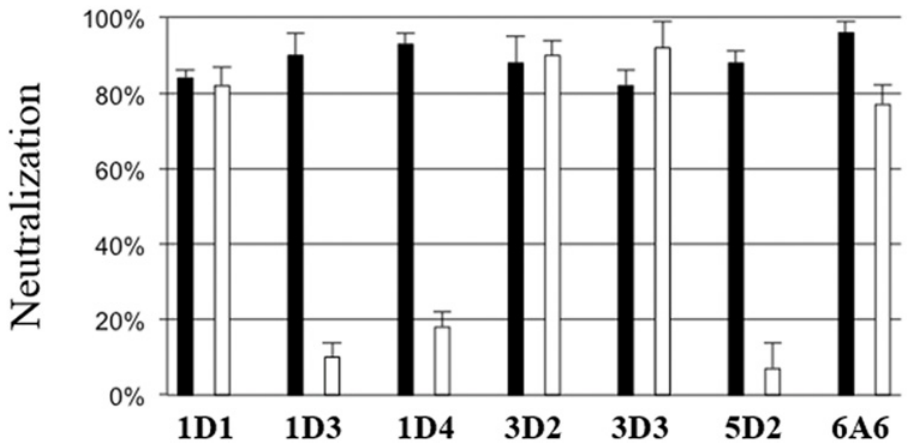
Fig 2. Monoclonal antibodies neutralization mechanism after pre (black) or post (white) MCPyV pseudovirions attachment. For the detection of neutralizing antibodies, COS-7 cells (10 4 /well) and MCPyV luciferase pseudovirions (0.2 RLU) were used. For the pre attachment determination, pseudovirions were mixed with monoclonal antibodies supernatants diluted 1:3 during 1 h and then added to the cells for 3 h at 37°C. The mixture was removed and 100 μ l of DMEM-FCS were added. For investigation of post-attachment neutralization, pseudovirions were bound to cells for 1 h at 4°C. Unbound virions were removed and then antibodies diluted 1:3 were added during 1h. The antibodies were removed and 100 μ l of DMEM-FCS were added. After incubation for 48 h at 37°C the luciferase activity was measure. The results were expressed as the percentage of inhibition of luciferase activity. The data presented are the means of three determinations performed in duplicate (+/- SEM).